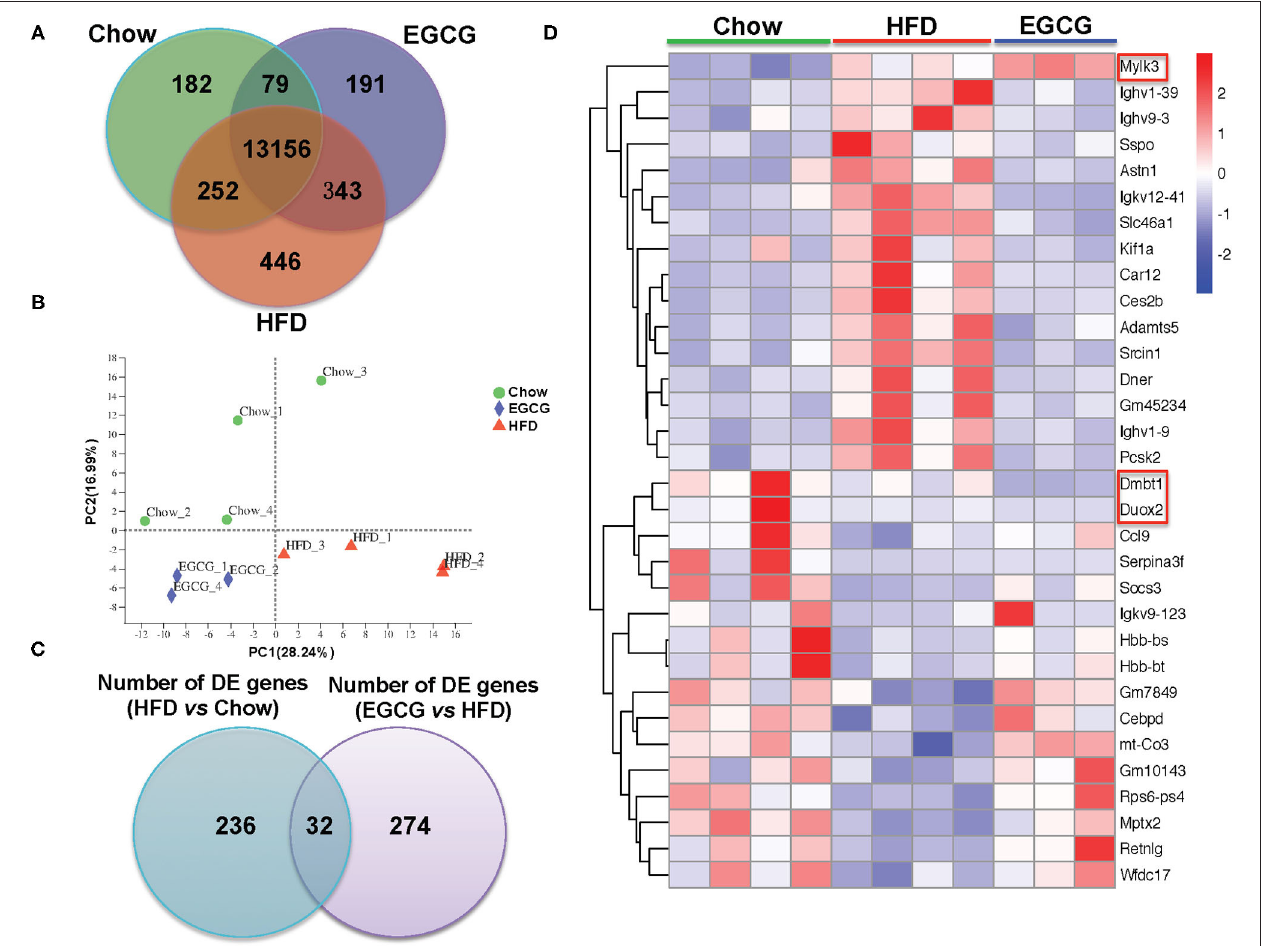
FIGURE 4 | General information of ileal transcriptome. (A) Venn diagram of expressed genes numbers with different treatments. Genes with mean TPM larger than one in each group were considered as expressed genes. (B) Principal Component Analysis (PCA) of samples with different treatments. (C) Venn diagram of DE genes between two comparisons (HFD vs. Chow, and EGCG vs. HFD). (D) Heatmap of common DE genes expression between two comparisons. Cutoff for the DE genes was FDR < 0.05 and FC > 2 or < −